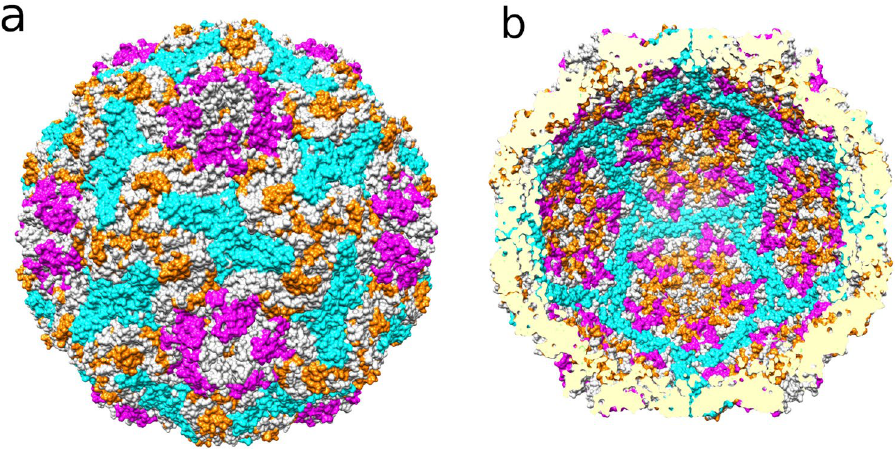
Figure 1. Results of whole-virion HPeV1 RCAP. The top hits arising from each of the capsid proteins from the virion RCAP are shown on the HPeV1 model (PDB: 4Z92). ( a ) Visualized on the outer surface of the capsid, all but one hit span the capsid and are exposed on the inner surface too. ( b ) Regions identified by RCAP visualized on the inner capsid surface. The peptides from VP0 are cyan, VP1 are magenta and VP3 are